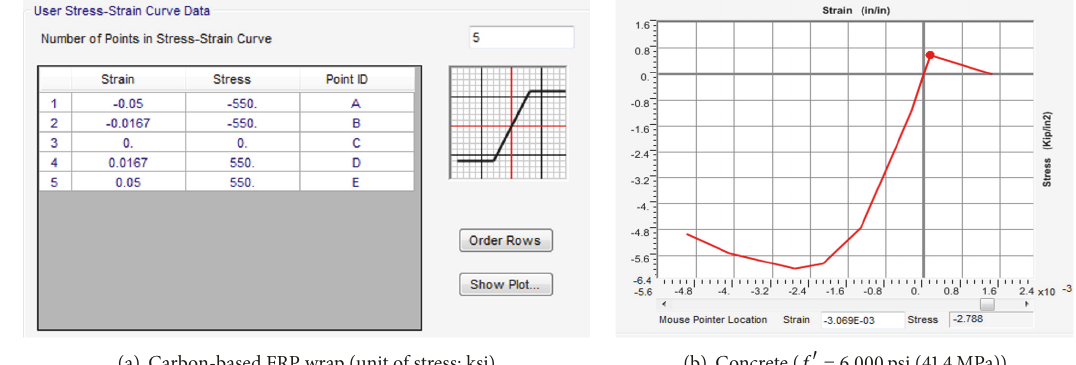
Figure 3: Stress-strain curve inputs used in the